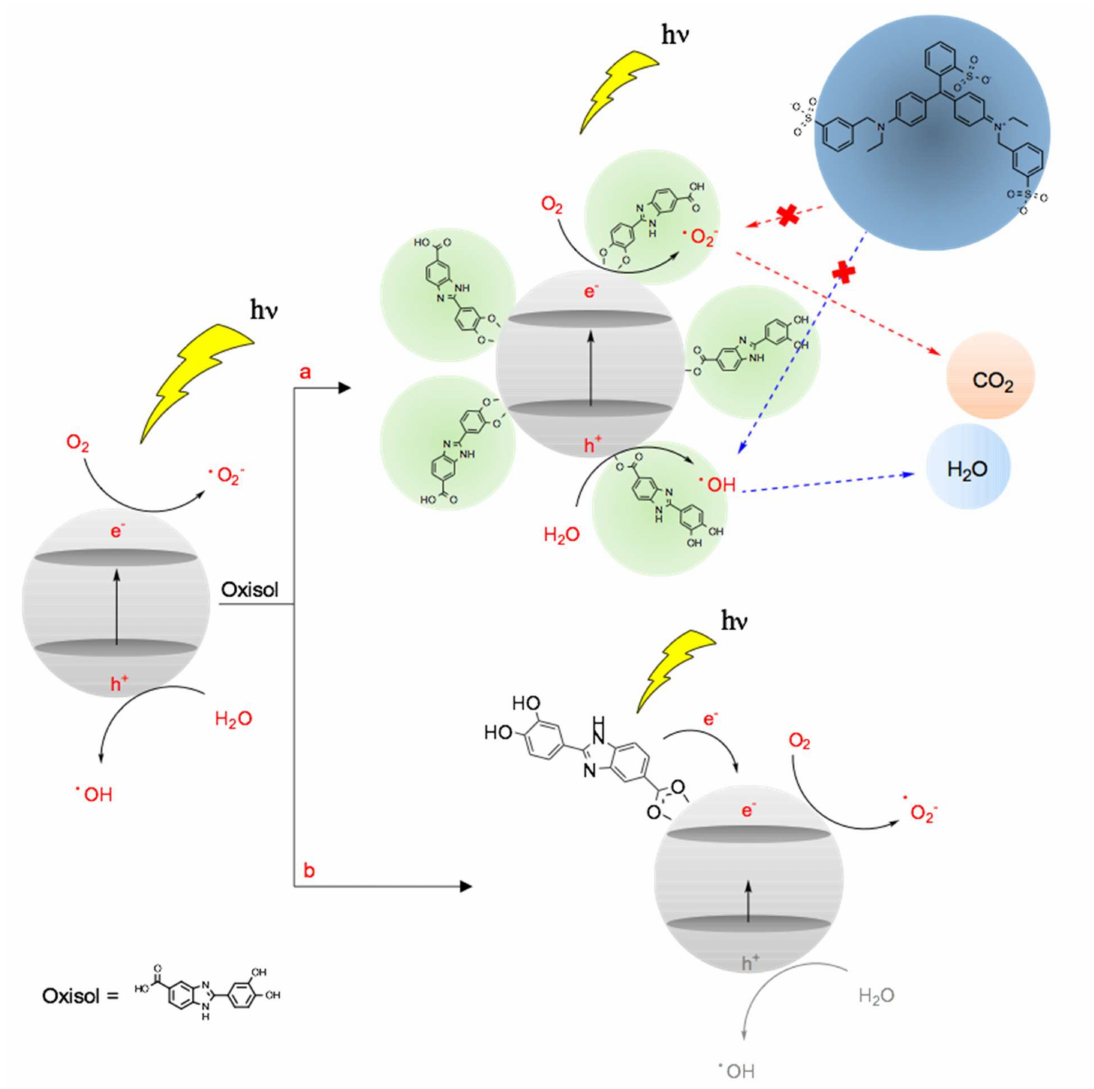
Figure 8. Possible mechanism of photocatalytic quenching. ( a ) Steric hindrance and ( b ) electron injection by ligand: after UV radiation the ligand direct inject electron in conduction band. This significant decrease the hole formation in valence band, then its oxidative activity. Both mechanisms could take place during the